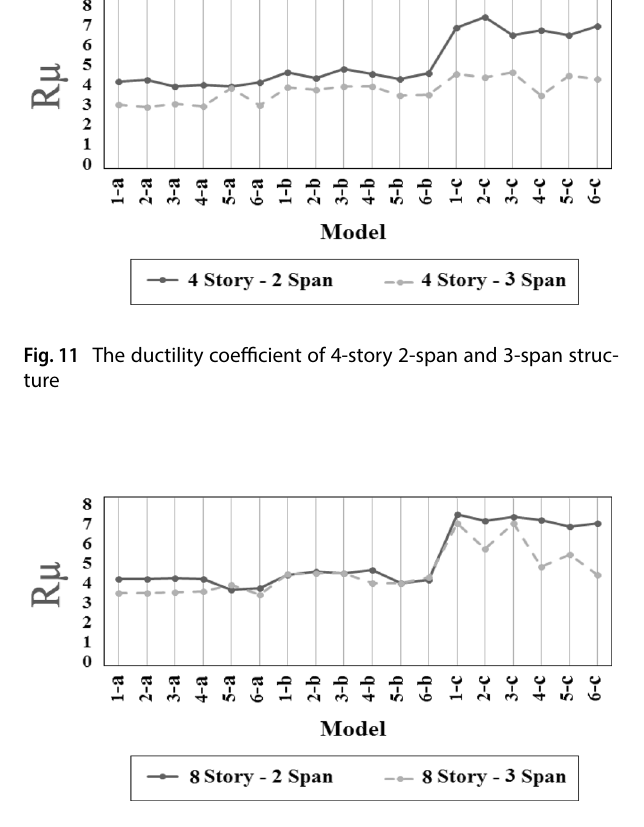
Fig. 12 The ductility coefficient of 8-story 2-span and 3-span struc- ture